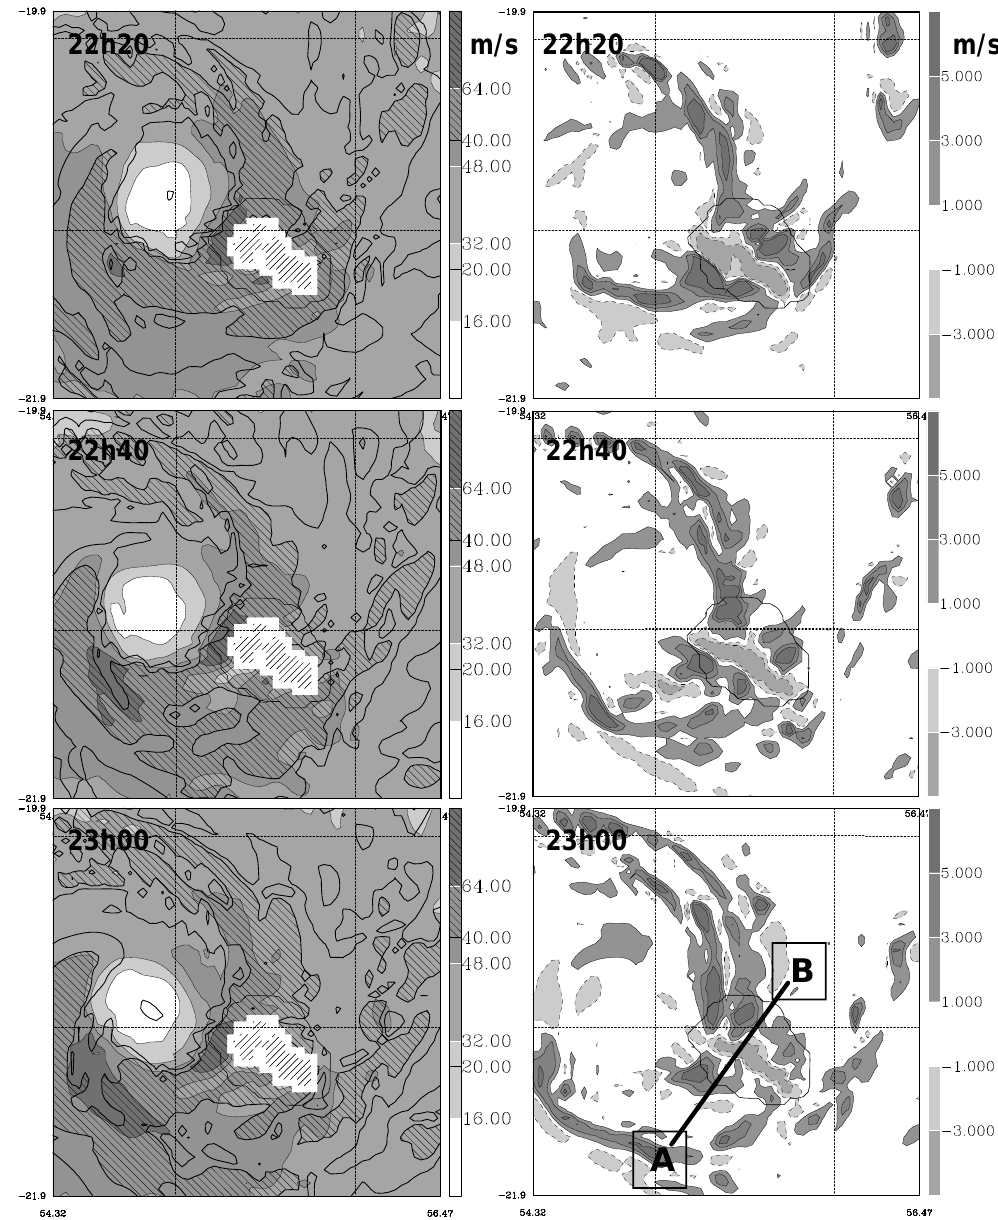
Fig. 12. As in Fig. 11, except for 22:20 to 23h. Line AB in the lower right panel shows the location of the southwest–northeast vertical cross section in Fig.